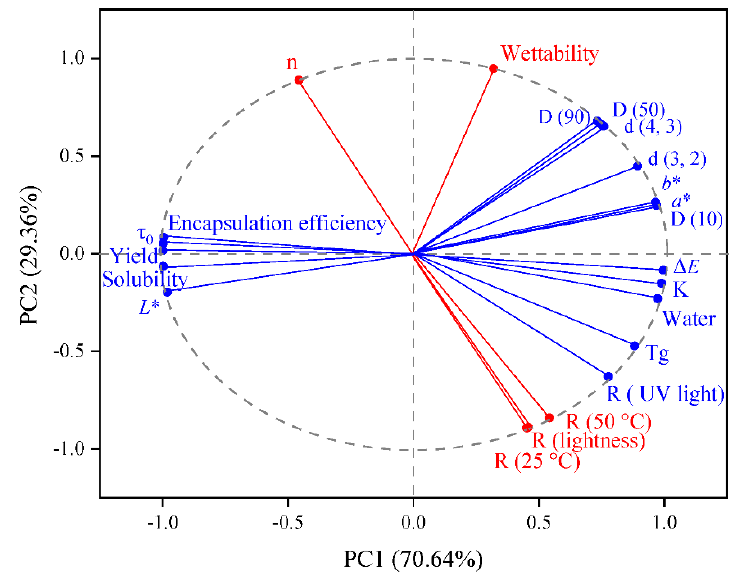
Figure 6. Principal component analysis of group differences.